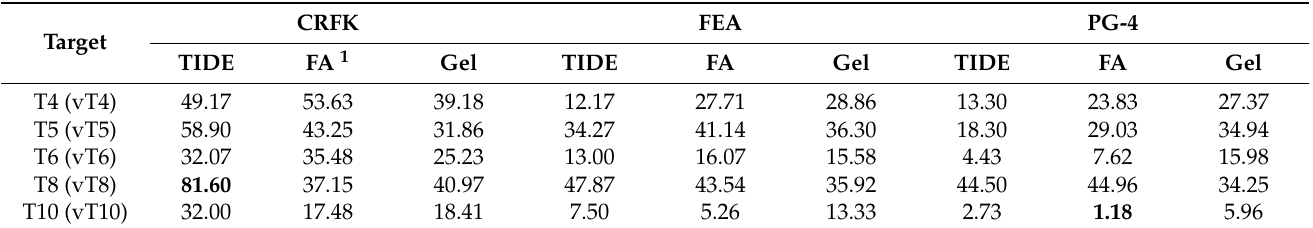
The mean frequency of indels of the triplicates is depicted. 1 FA: Fragment Analyzer. In bold are the highest and lowest percentages of NHEJ.